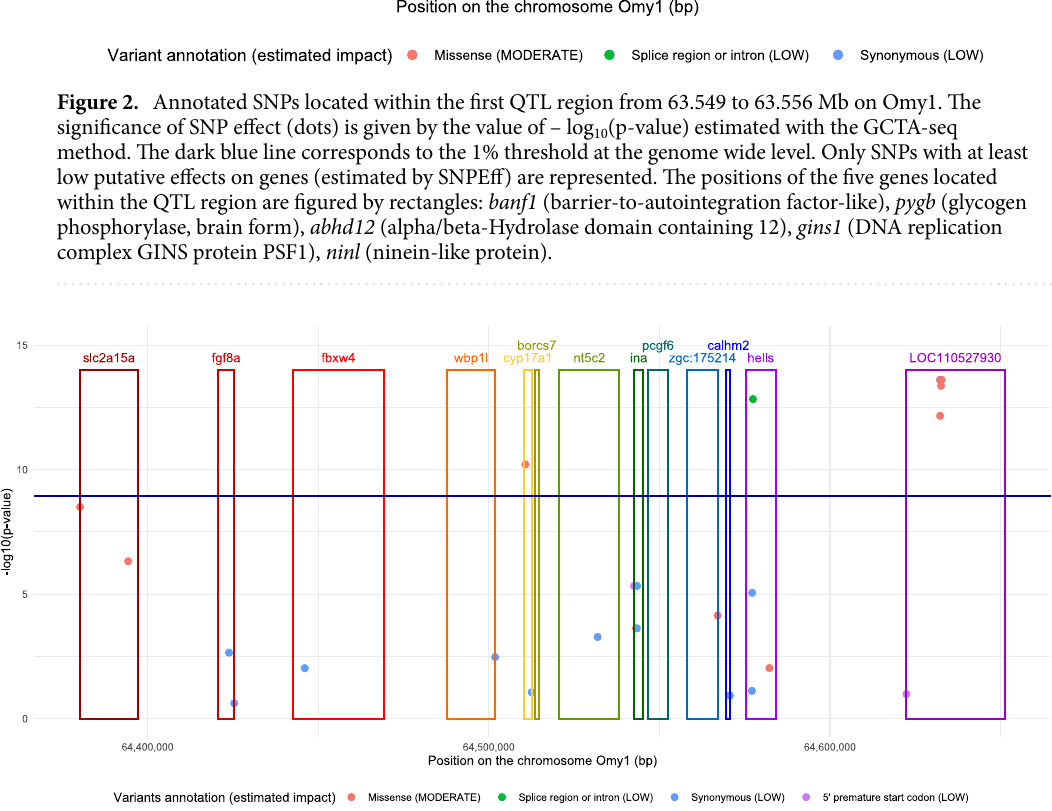
Figure 3. Annotated SNPs located within the second QTL region, from 64.360 to 64.633 Mb on Omy1. The significance of SNP effect (dots) is given by the – log 10 (p-value) estimated with the GCTA-seq method. The dark blue line corresponds to the 1% threshold at the genome wide level. Only SNPs with at least low putative effects on genes (estimated by SNPEff) are represented. Genes located within this QTL are represented by rectangle: slc2a15a (solute carrier family 2, facilitated glucose transporter member 9-like), fgf8 (fibroblast growth factor 8), fbxw4 (F-box/WD repeat-containing protein 4), wbp1l (WW domain binding protein 1-like), cyp17a1 (Cytochrome P450 Family 17 Subfamily A Member 1), borcs7 (BLOC-1-reltaed complex subunit 7), nt5c2 (cytosolic purine 5 ′ -nucleotidase), ina (alpha-internexin), pcgf6 (polycomb group RING finger protein 6), zgc:175214 (RING finger protein 122-like), calhm2 (calcium homeostasis modulator protein 2), hells (lymphocyte-specific helicase-like), LOC110527930 (uncharacterized